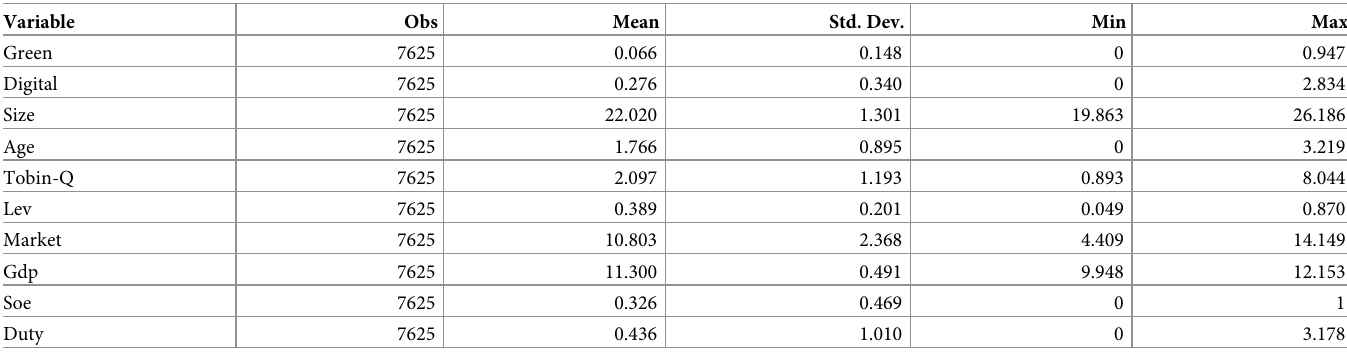
Table 2. Descriptive